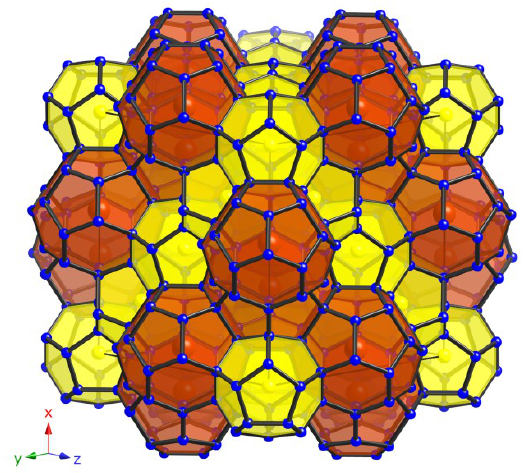
Figure 1. View of the polyanionic framework of clathrates with type-II structure (yellow: pentagonal dodecahedra; red: hexakaidecahedra).